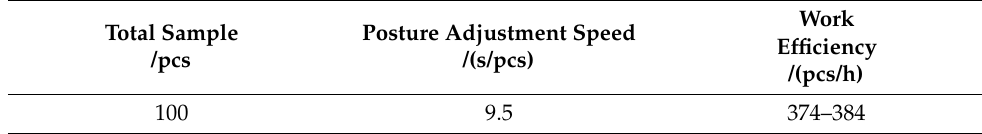
Table 6. Apple posture adjustment device experimental